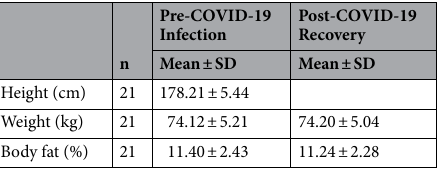
Table 3. Anthropometric and body composition characteristics pre- and pos- COVID-19.